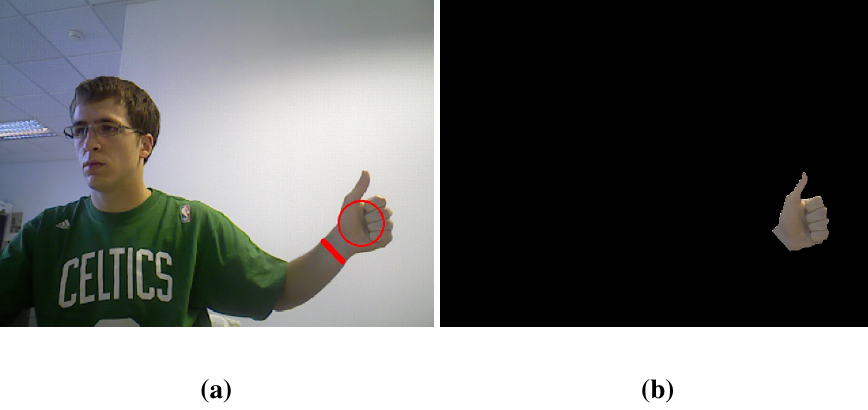
Figure 4. Hand extraction: ( a ) Palm circle and wrist segment identification; ( b ) Hand